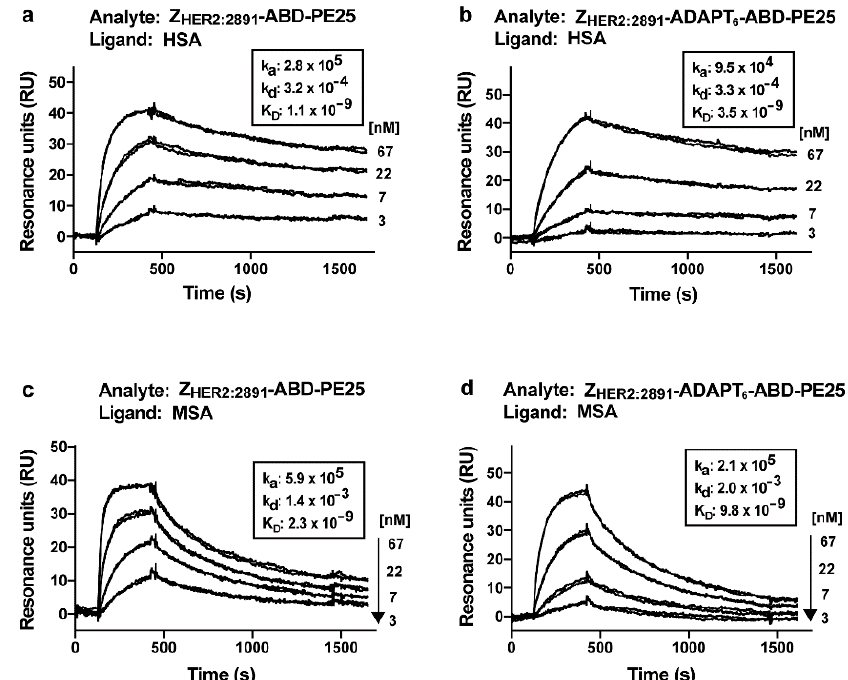
Figure 3. Analysis of the interaction between the fusion toxins and HSA and mouse serum albumin (MSA). The analyses were carried out a Biacore real-time biosensor instrument. A dilution series of Z HER2:2891 -ABD-PE25 was injected over a surfaces with immobilized HSA ( a ); a dilution series of Z HER2:2891 -ADAPT 6 -ABD-PE25 was injected over a surface with immobilized HSA ( b ); a dilution series of Z HER2:2891 -ABD-PE25 was injected over a surfaces with immobilized MSA ( c ); a dilution series of Z HER2:2891 -ADAPT 6 -ABD-PE25 was injected over a surface with immobilized MSA ( d ). The concentrations are indicated to the right of each panel. Each concentration was injected twice and each panel is an overlay of the sensorgrams recorded for both repeats of each concentration for the whole dilution series.